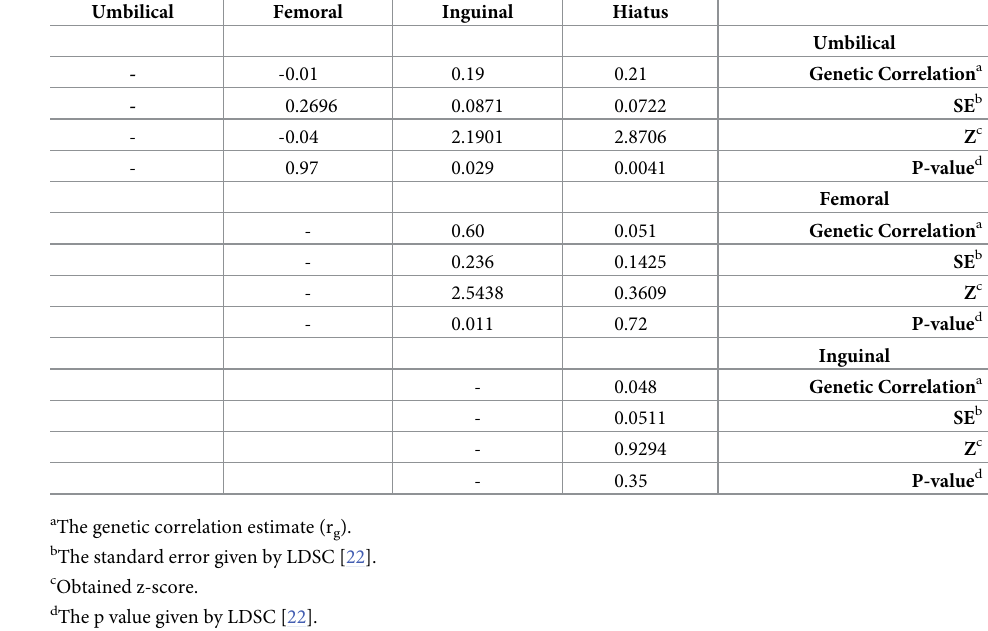
Table 6. Genetic correlations of individual hernia phenotypes with LDSC. Umbilical